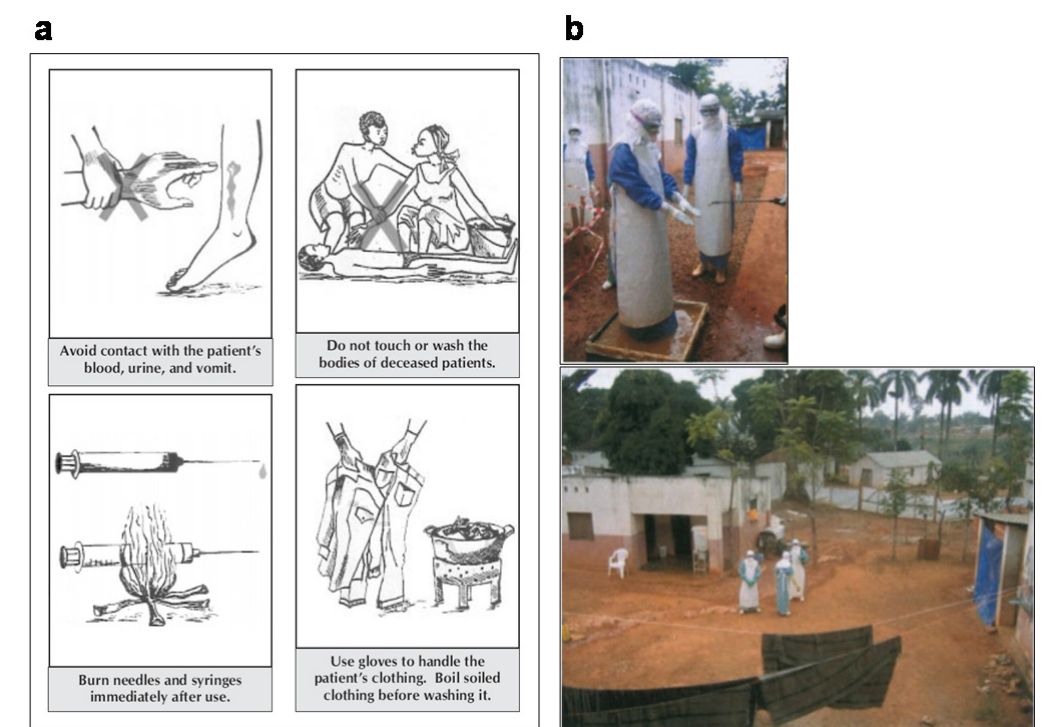
Figure 3. Marburg virus disease outbreak control. (a) Signs used to educate the local population in outbreak areas. Picture taken from [57]. (b) Pictures of the MVD outbreak in Angola, 2005. Above, nurse being sprayed with chlorine while leaving the isolation ward. This illustrates the protective clothing worn by nursing staff. Below, view showing a section of the isolation ward. The ward for confirmed MARV patients is on the left. The solid plastic sheeting used for the outer wall is shown in the distance. Figure and legend modified from